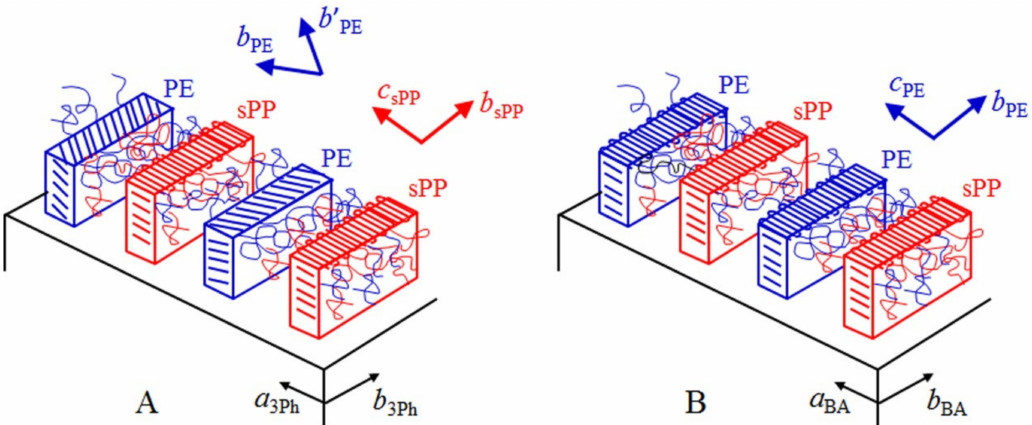
Figure 7. Models of the structures and morphologies that develop upon epitaxial crystallization of PE- b -sPP with f PE = 13% onto the (001) surfaces of crystals of 3Ph ( A ) and BA ( B ). In A sPP crystallizes first onto 3Ph, forming lamellae aligned with the c and b axes of sPP parallel to the a and b axes of 3Ph. PE crystallizes after sPP in the confined inter-lamellar regions prescribed by the oriented sPP lamellae ( A ). In B PE crystallizes first onto BA forming lamellae aligned with the c and b axes of PE parallel to the a and b axes of BA. sPP crystallizes after PE in the confined inter-lamellar regions prescribed by the oriented PE lamellae ( B